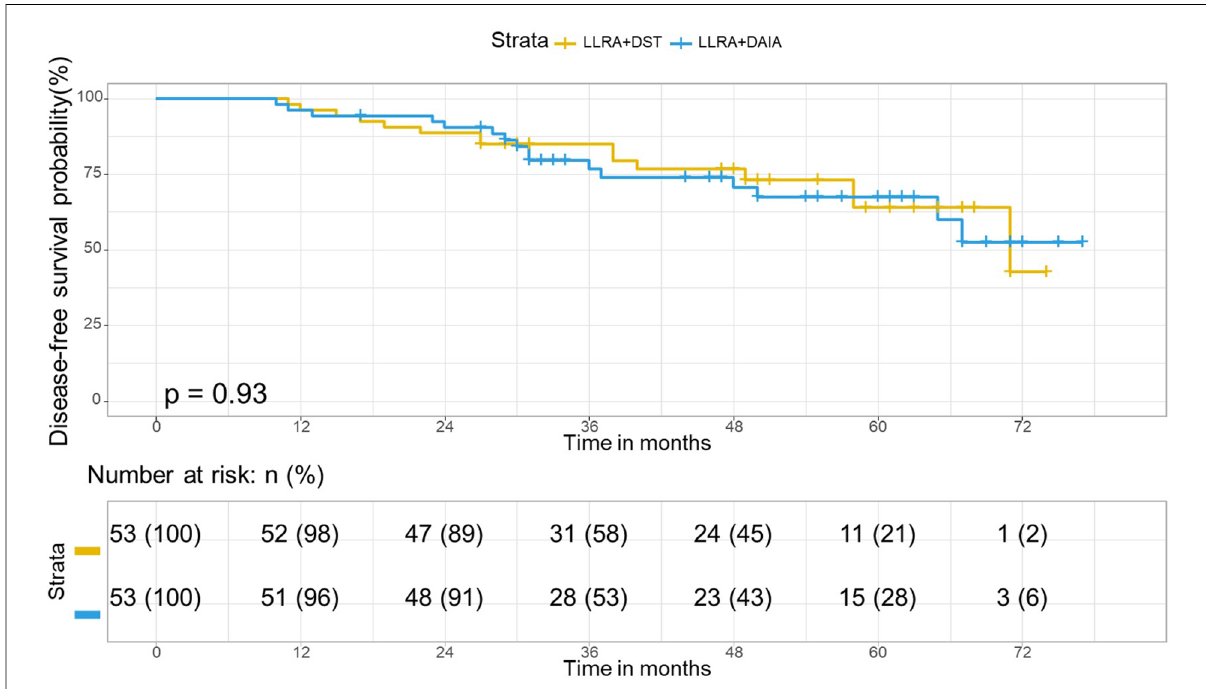
FIGURE 5 Disease-free curve in matched cohort of LLAR+DST and LLAR+DAIA groups. In the matched cohort, in the LLAR+DST group, 3- year and 5-year disease-free survival rates were 79.2 and 63.7% respectively and they were 76.5 and 67.2% respectively in the LLAR+DAIA group. There was no signi fi cant difference between the LLAR+DST and LLAR+DAIA groups ( P